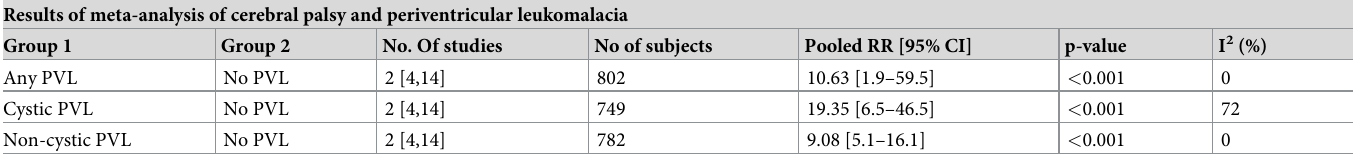
CI, confidence interval; PVL, periventricular leukomalacia; Ref, reference number; RR, Risk